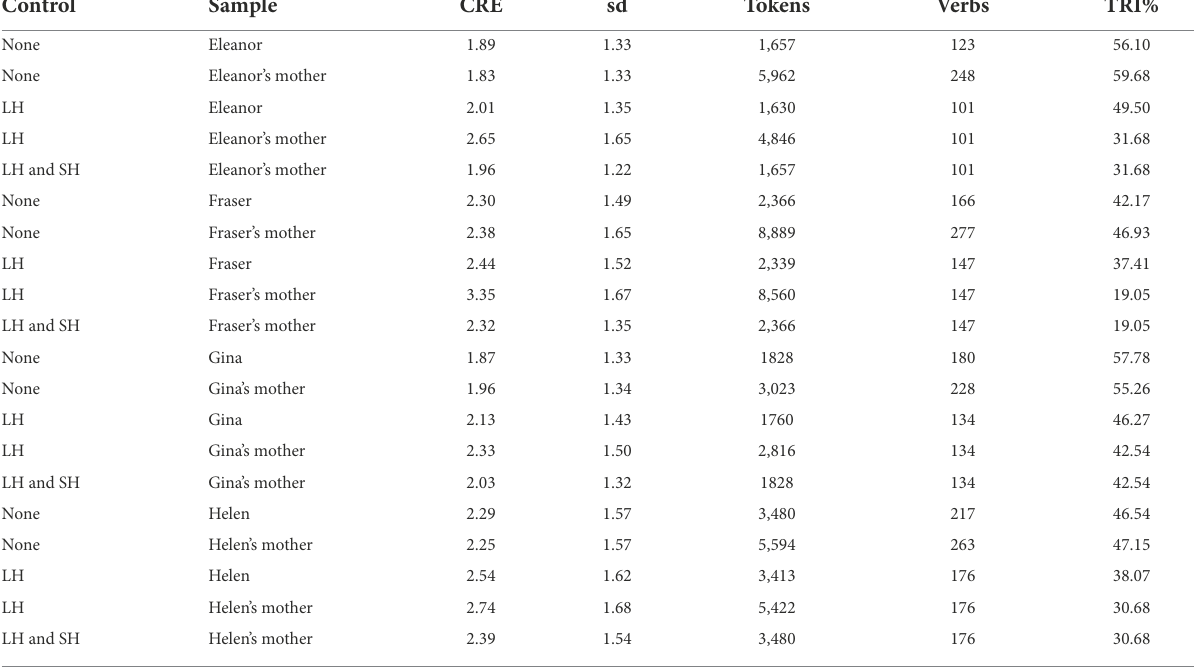
TABLE 4 Descriptive results of the productivity observed in the speech of English-speaking children and their respective caregivers.